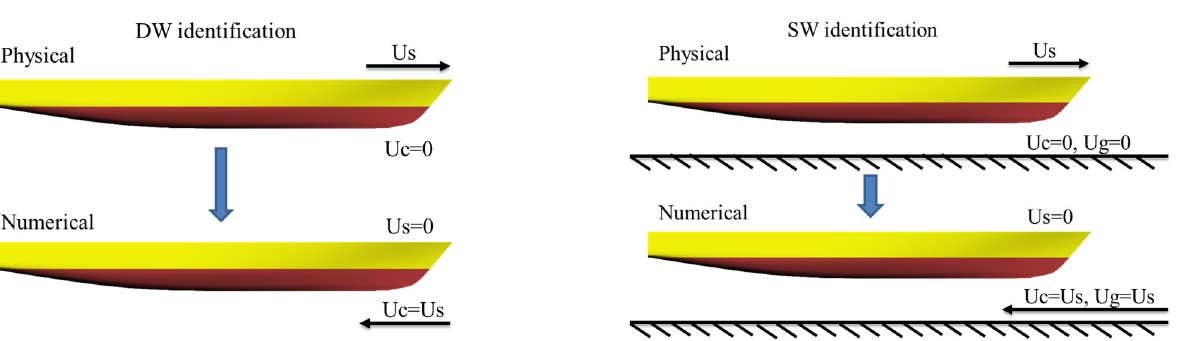
Figure 8. Illustrations for the identical numerical set ‐ up for deep water ( left ) and shallow water ( right